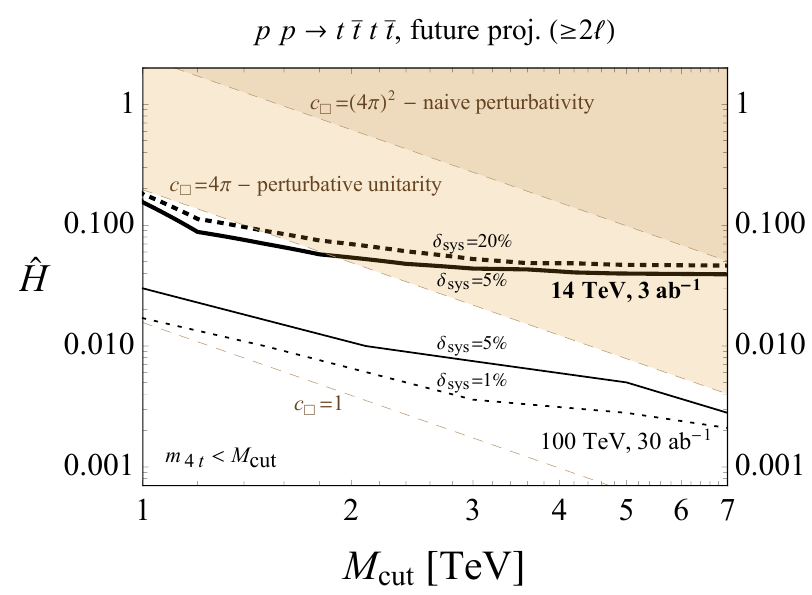
1 HL-LHC and 30 ab 1 FCC-hh sensitivity projections for the ^ H parameter Figure 5 . The 3 ab (cid:0) (cid:0) in four-top production ( pp ! t (cid:22) tt (cid:22) t ). The solid and dashed black curves show the expected sensitivity at 95% CL as a function of the kinematic variable M cut for a di(cid:11)erent systematic uncertainty (cid:14) sys . Superimposed to this plot are three dashed brown lines showing the corresponding values of c (cid:3) assuming M = M cut . The regions above the lines c (cid:3) = 4 (cid:25) and c (cid:3) = (4 (cid:25) ) 2 are incompatible